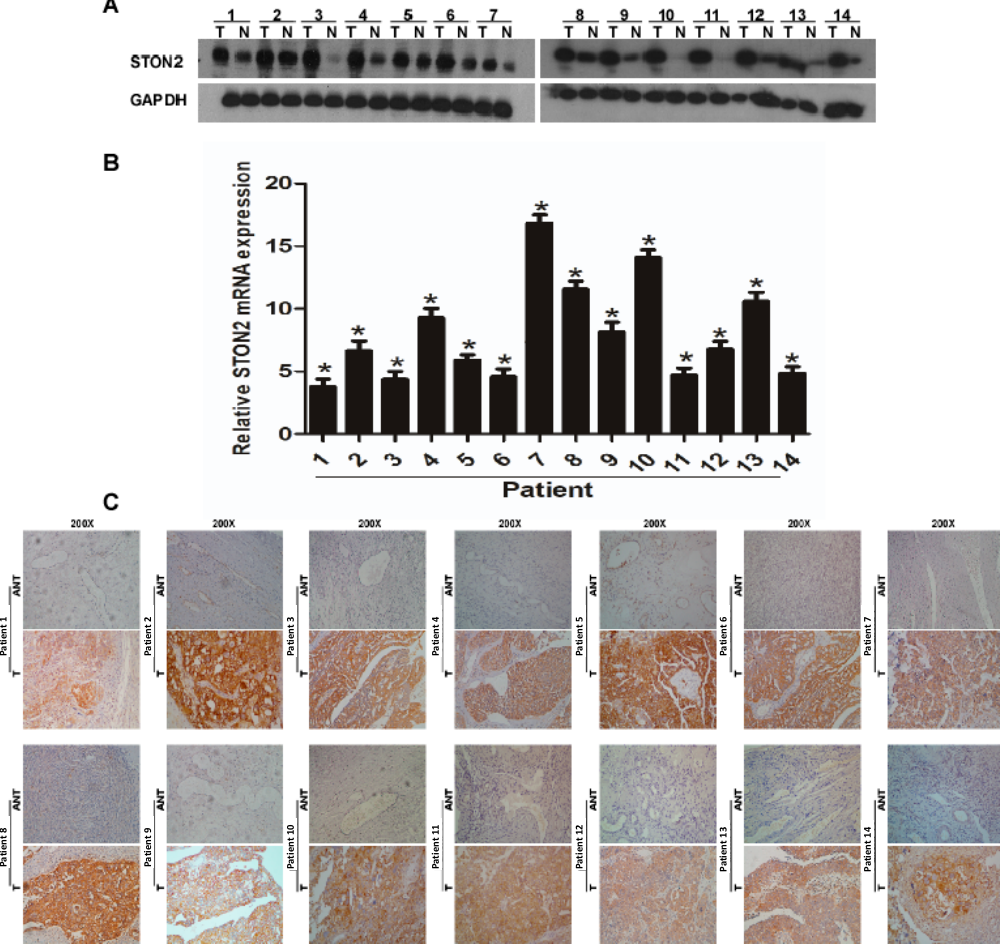
Figure 2. Overexpression of STON2 mRNA and protein in ovarian cancer tissues. ( A ) Representative Western blots of STON2 protein expression in 14 matched pairs of ovarian cancer (T) and adjacent noncancerous tissues (N). GAPDH was chosen as the loading control. ( B) Average T/N ratios of STON2 mRNA expression in paired ovarian cancer (T) and adjacent noncancerous tissues (N) were quantified by real-time PCR and normalized against the expression of GAPDH . Error bars, standard deviation (SD) of the mean calculated from three parallel experiments. ( C) Immunohistochemical (IHC) assay of STON2 protein expression in 14 pairs of matched ovarian cancer tissues ( * p <